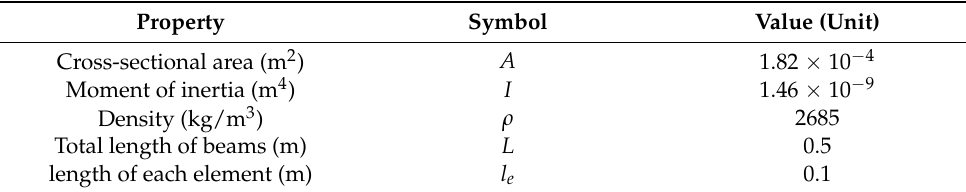
Figure 3. The considered beam in numerical investigation. Table 1. The constant properties of the studied beam structure.